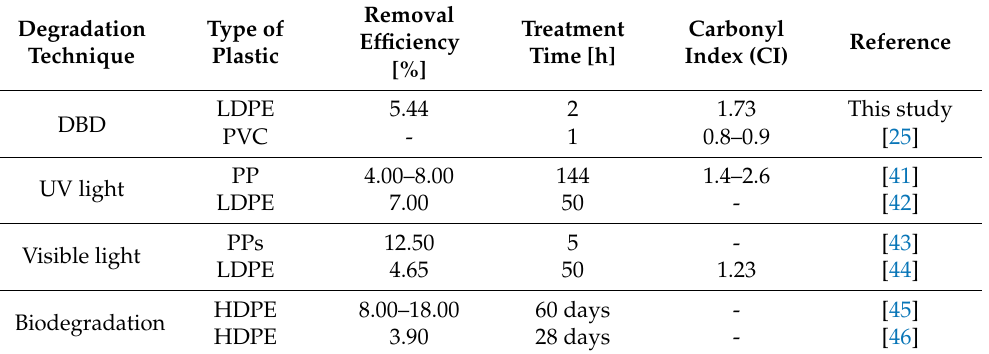
Table 2. An overview of microplastic degradation utilizing various techniques in recent